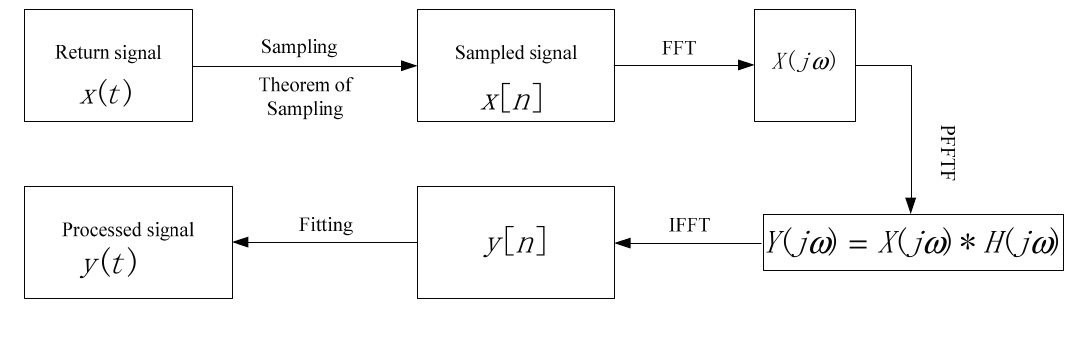
Figure 4. Procedure of